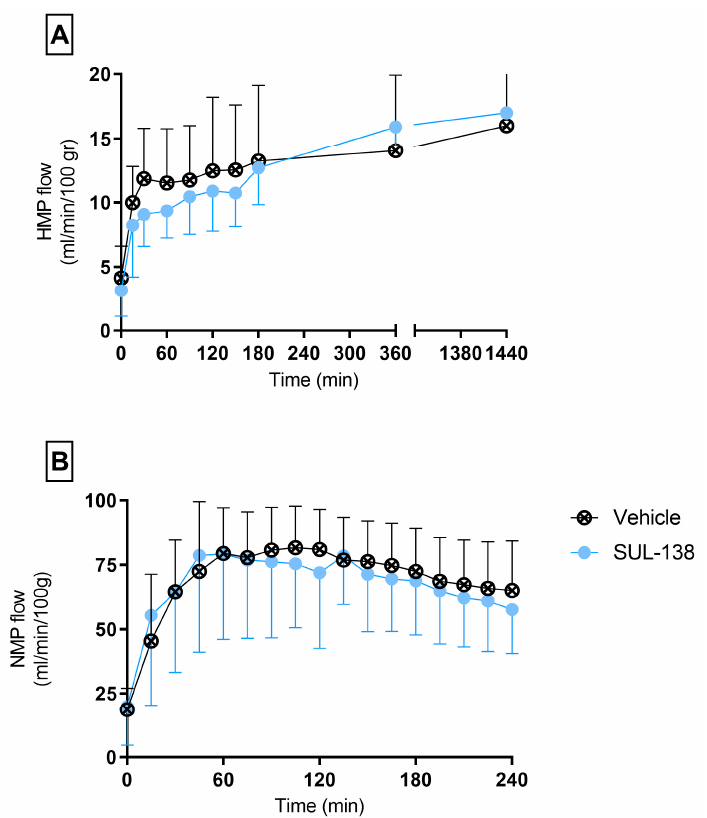
Figure 1. Flow rates during preservation and testing. Porcine kidneys were preserved with HMP with SUL-138 ( • ) and without the addition of SUL—138 (Vehicle ⊗ ) for 24 h. ( A ) HMP flow rates during preservation, ( B ) Renal flow rates during normothermic functionality testing. HMP, hypothermic machine perfusion. The data are shown as mean ± SD.